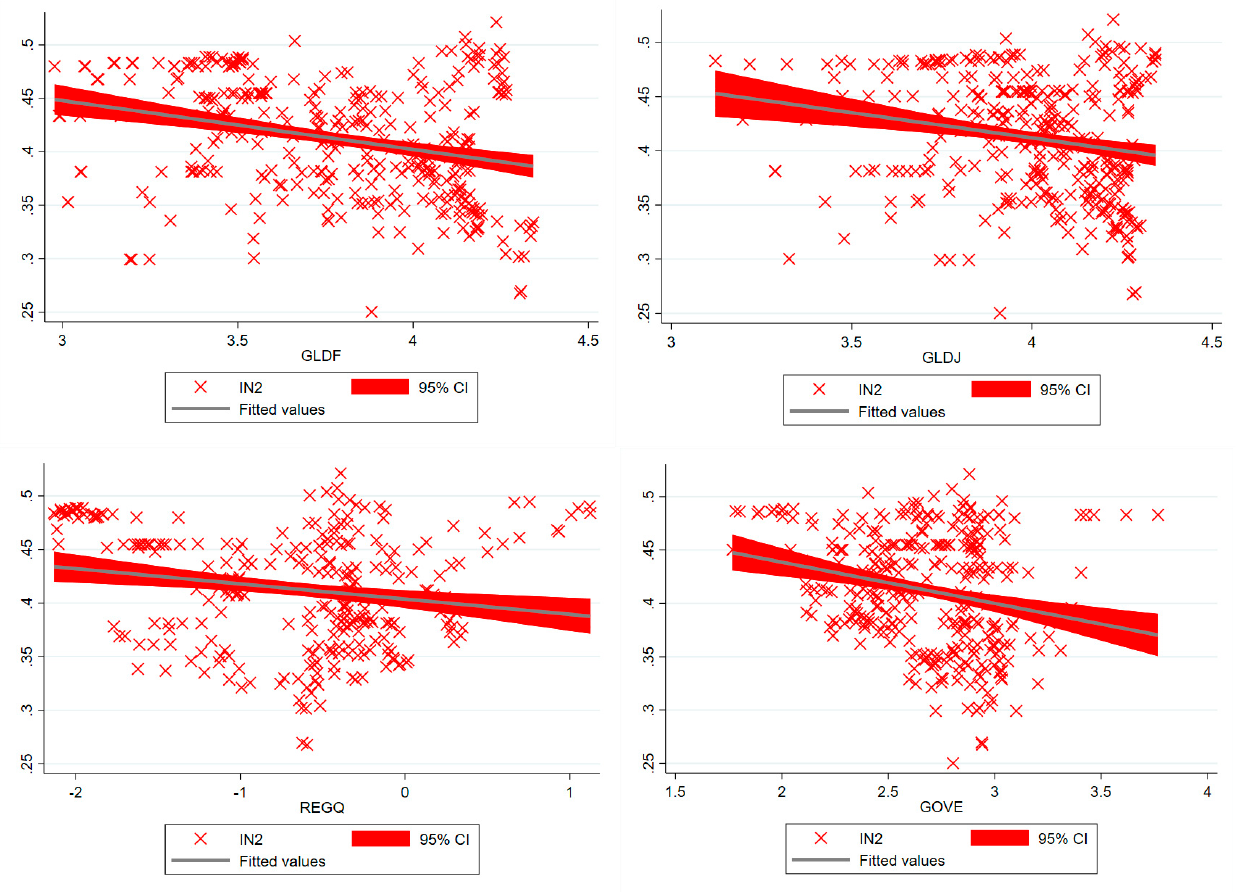
Figure 3. Fitted values for income inequality and globalization dynamics. Note: CI—Confidence interval. Legend: IN2—The income share of the top 10%, GLDF—Globalization de facto; GLDJ— Globalization de jure .